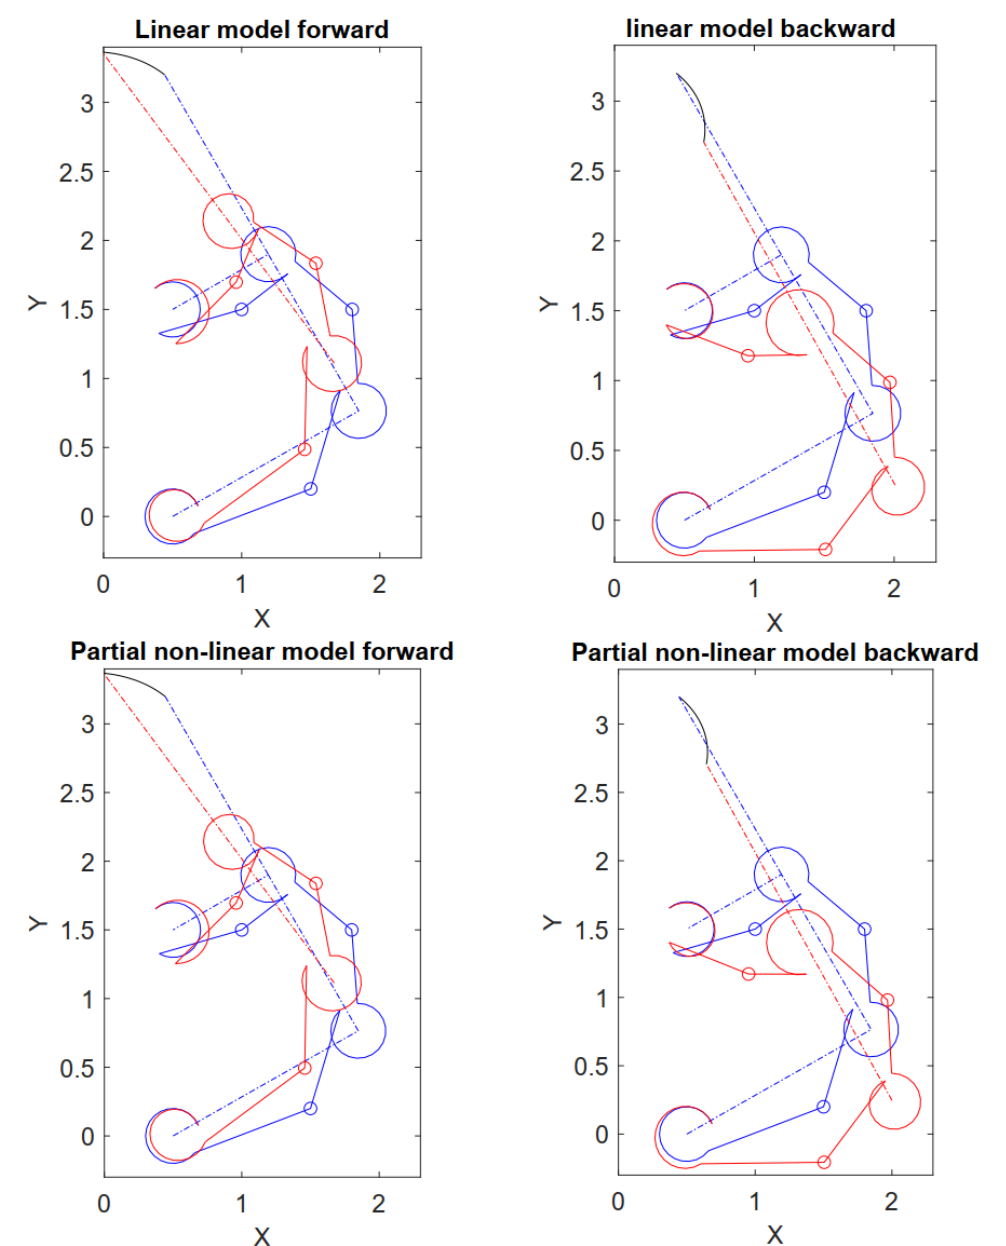
Figure 7. Workspace of the gripper and end-effector trajectory for the linear and partial non-linear models during the opening/closing maneuver: (red) deformed configuration, (blue) undeformed configuration, (black) end-effector trajectory. Units in